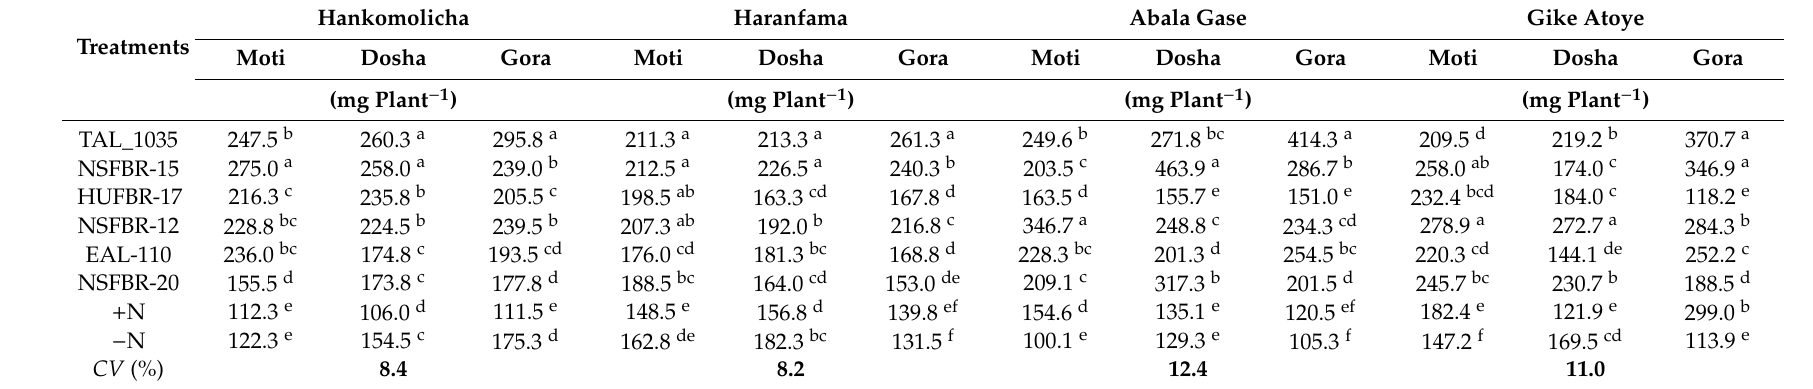
Table 3. Rhizobium strain and faba bean variety interaction e ff ects on nodule dry weight at the study